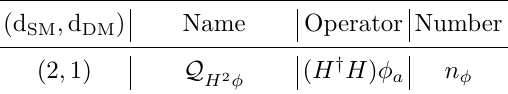
Table 8 . Dimension-three ∆ B = ∆ L = 0 operator in DSMEFT. The first column gives the dimensions of the SM and DM part of the operator, and the fourth column is the number of operators.